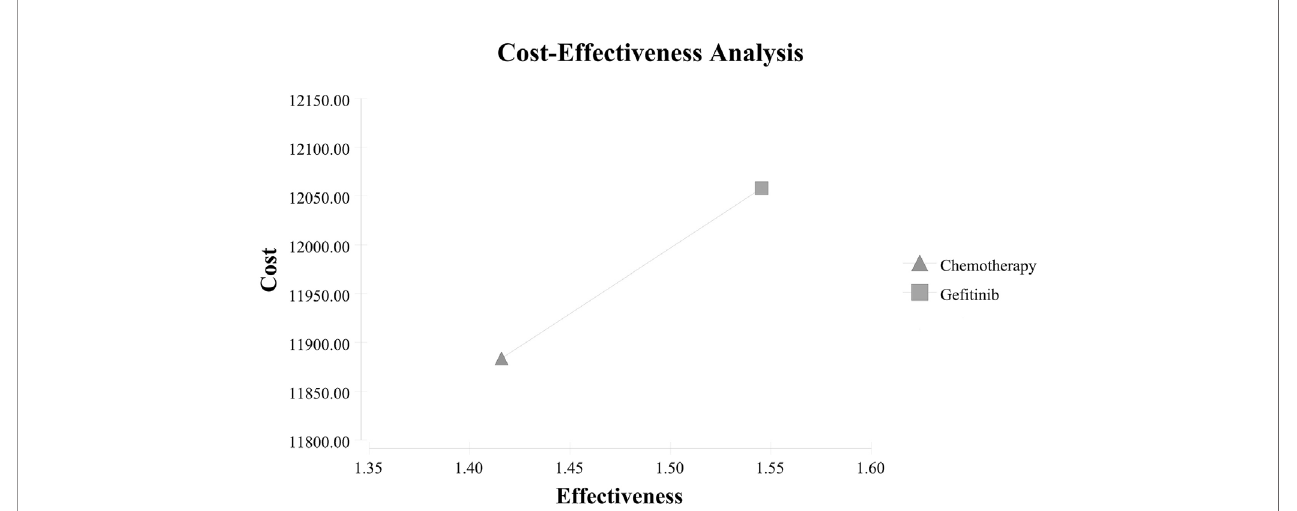
FIGURE 2 | Results of cost-effectiveness analysis.